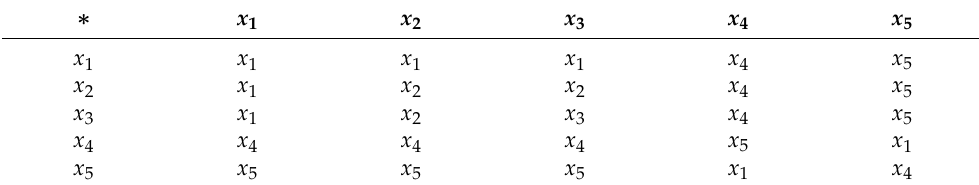
Table 7. A power cancellative T2CA-groupoid of Example